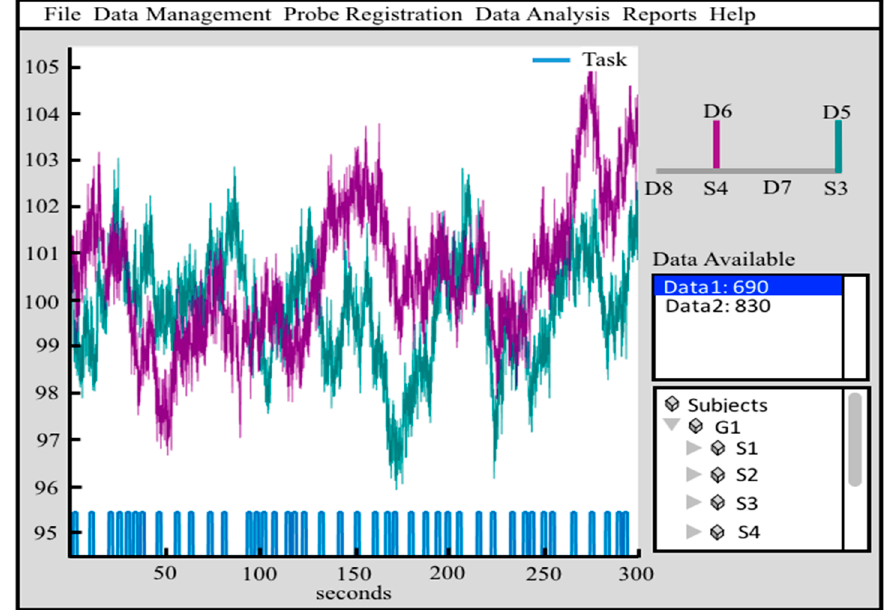
Figure 7. Graphical user interface of AnalyzIR toolbox.